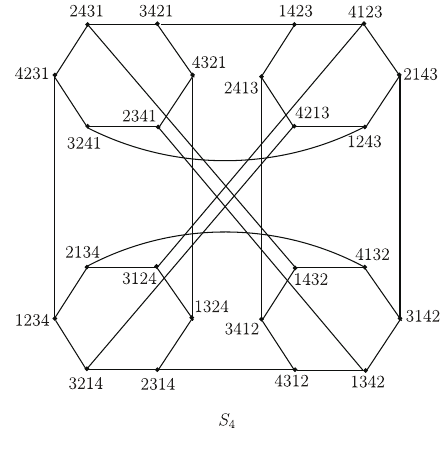
Figure 1: The graph of S 4